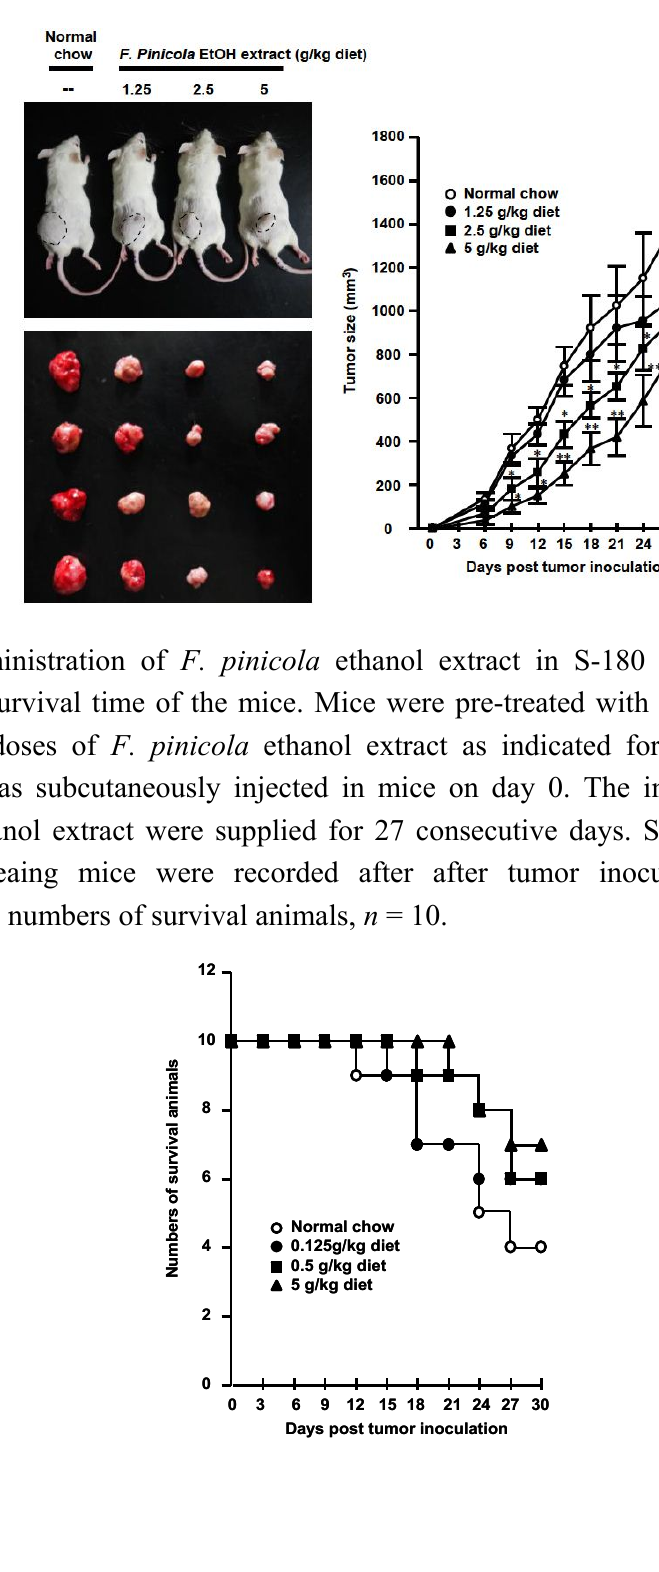
Figure 4. Administration of F. pinicola ethanol extract in S-180 tumor-bearing mice decreased tumor size and prolonged the survival time of the mice. Mice were pre-treated with a diet supplemented with different doses of F. pinicola ethanol extract as indicated for 3 days. Solid-type sarcoma S-180 was subcutaneously injected in mice on day 0. The indicated amounts of F. pinicola ethanol extract were supplied for 27 consecutive days. The tumor volume was determined by direct measurement with calipers and calculated every 3-day. Results are expressed as means ± S.E.M. n = 10. * p < 0.05 and ** p < 0.01 compared with normal chow group.